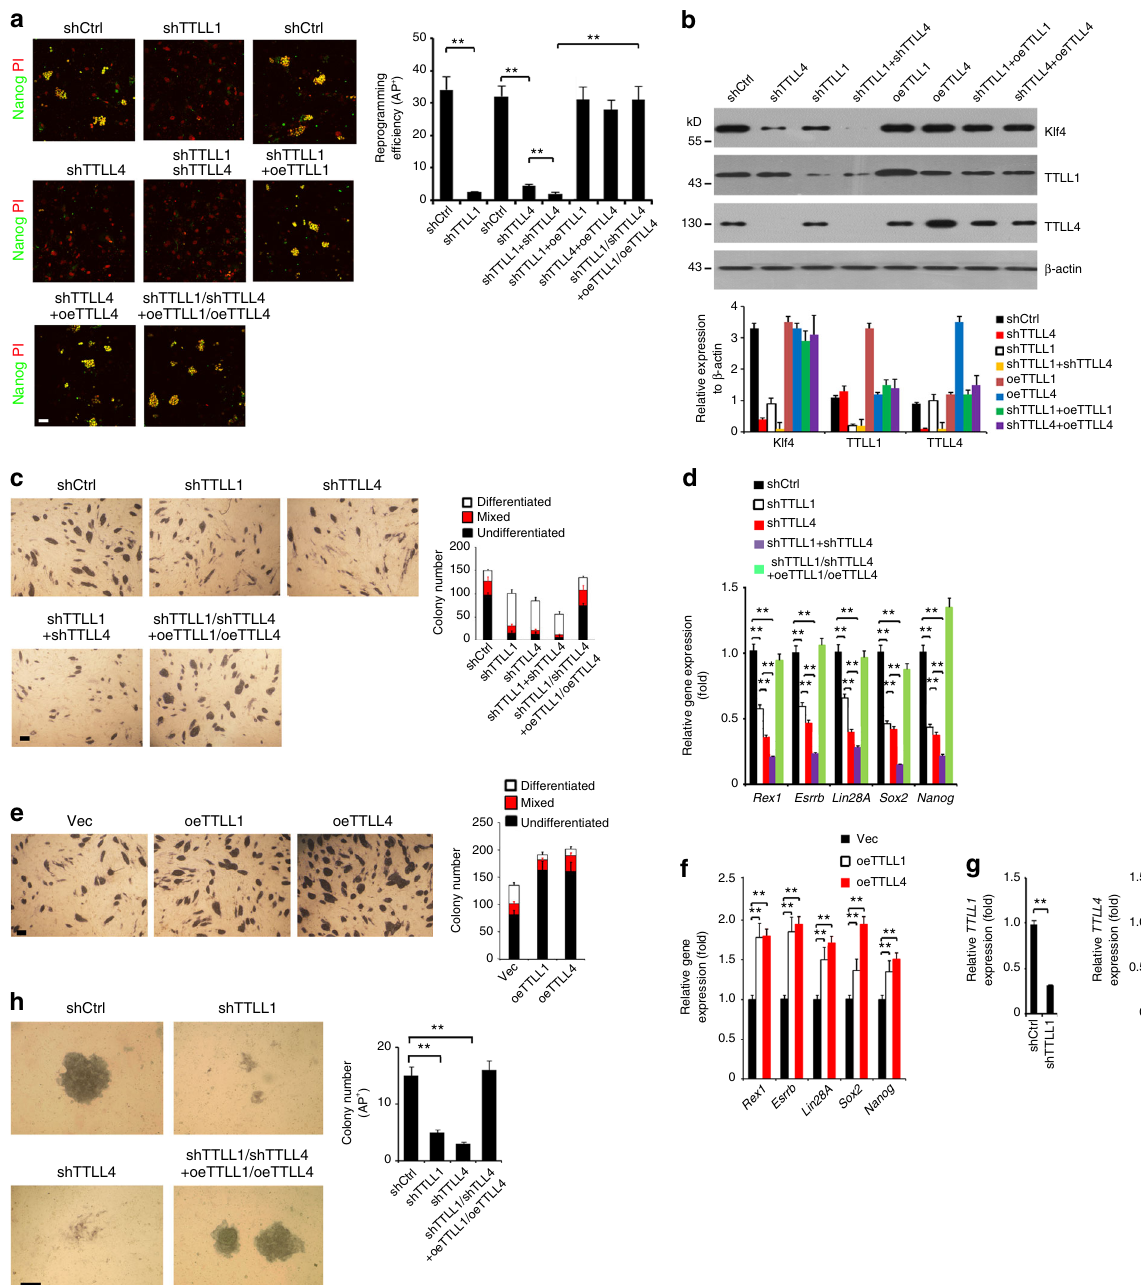
Fig. 7 Deletion of TTLL1 or TTLL4 impairs iPSC induction and ESC pluripotency. a Depletion of TTLL1 or TTLL4 impairs iPSC formation. TTLL1 or TTLL4 was silenced in 4F2A MEFs as well as rescued with TTLL1 or TTLL4 into their silenced MEFs, followed by dox treatment for iPSC formation and stained